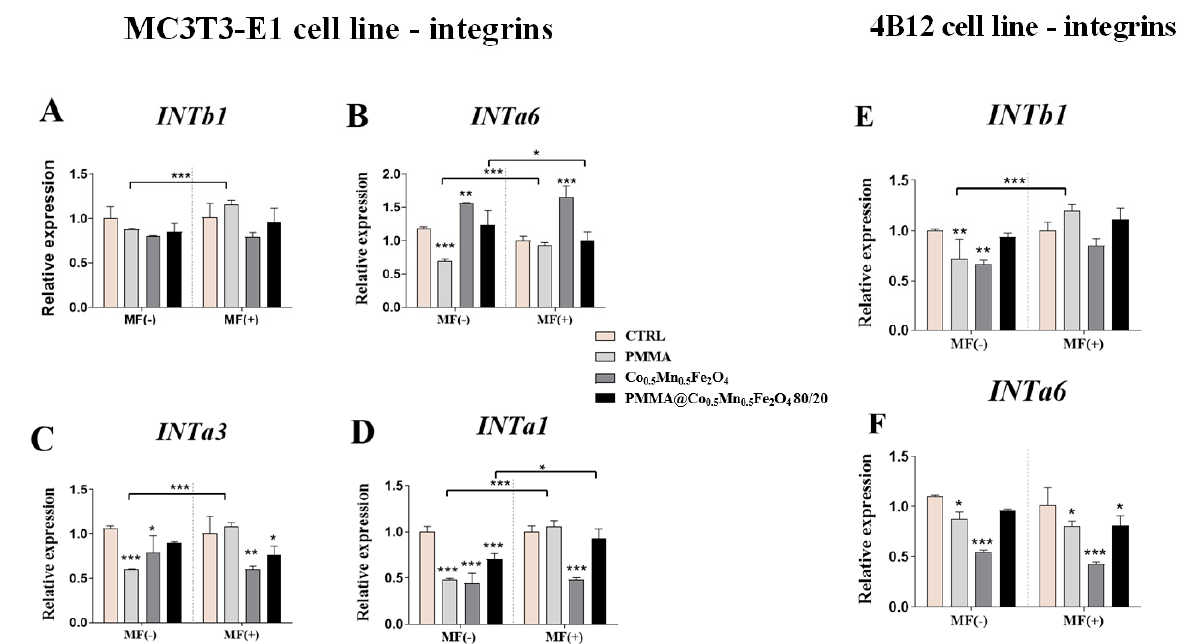
Figure 9. The impact of PMMA and its modification on the integrins expression in the magnetic field condition towards mouse pre-osteoblasts (MC3T3-E1 cell line) Intb1 ( A ), Inta6 ( B ), Inta1 ( C ), Inta3 ( D ) and mouse pre-osteoclasts (4B12 cell line) Intb1 ( E ), Inta6 ( F ). Notes: CTRL—control, PMMA—poly(methyl (methylacrylate)), Co—Co 0.5 Mn 0.5 Fe 2 O 4 , PMMA+ Co— Co 0.5 Mn 0.5 Fe 2 O 4 @PMMA in ratio 80/20. Statistical differences are indicated by * p < 0.005; ** p < 0.001 and *** p < 0.0001.